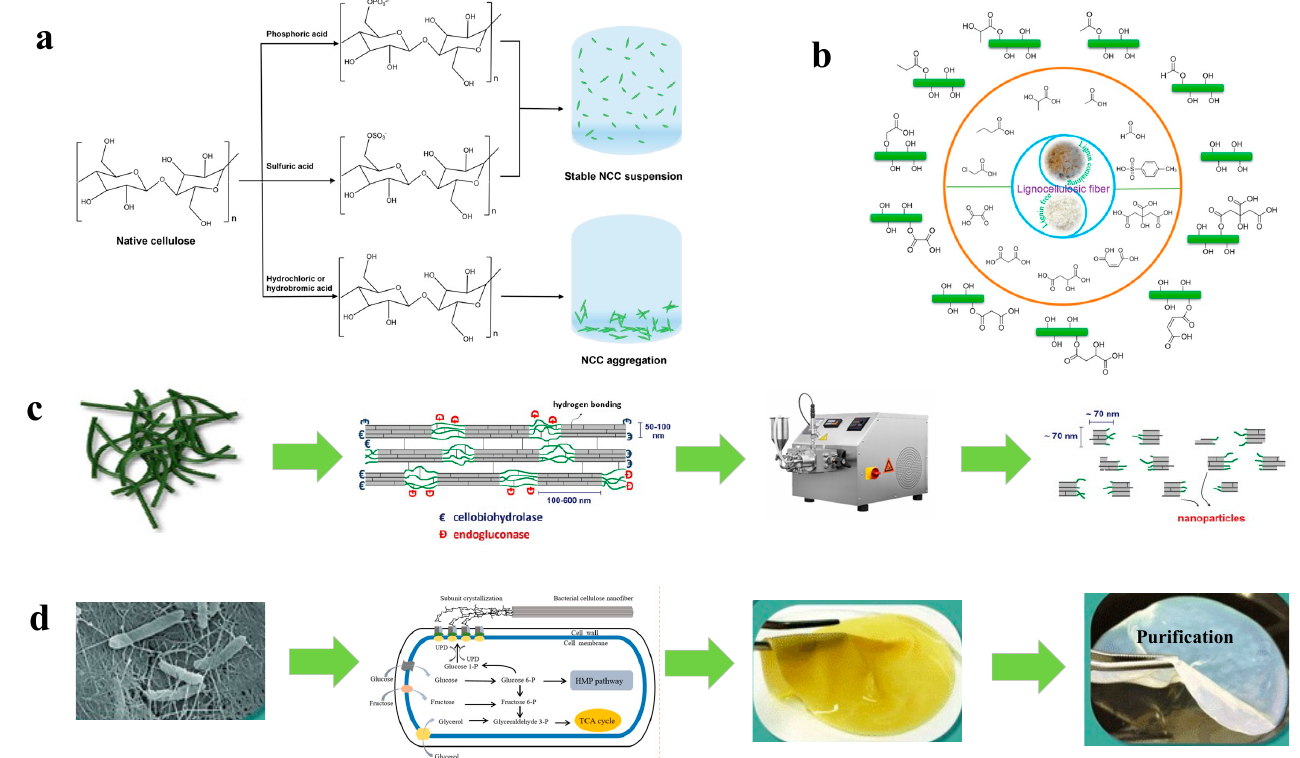
Figure 6. Different preparation methods of nanocellulose ( a ) inorganic acid hydrolysis, reprinted with permission from [98] , 2022, Elsevier; ( b ) organic acid hydrolysis, reprinted with permission from [99] , 2021, Elsevier; ( c ) mechanical treatment, reprinted with permission from [71] , 2022, Elsevier and [100] , 2021, Elsevier; ( d ) microbial synthesis, reprinted with permission from [101] , 2022, Elsevier and [37] , 2019, Frontiers Media S.A.